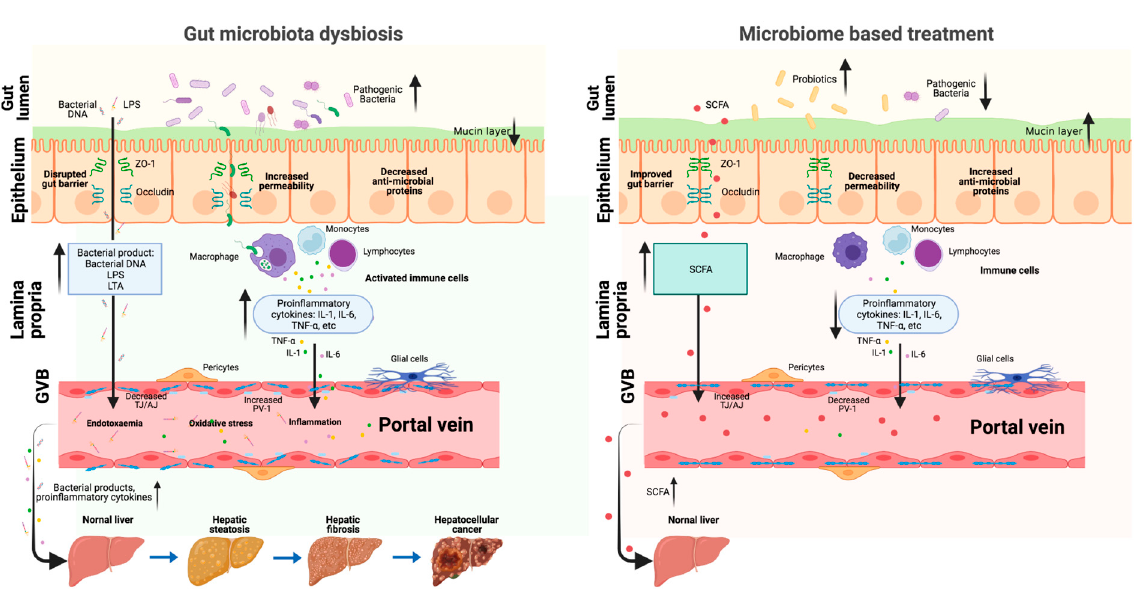
Figure 2. The role of gut–liver axis in the gut microbiota dysbiosis and microbiome-based NAFLD treatment. When the gut microbiota is in homeostasis, it is difficult for the pathogenic bacteria and metabolites to go through the intestinal barrier and reach the liver. When the gut microbiota is dysbiosis, the intestinal barrier is damaged (decreased mucus layer, increased epithelium, and endothelium layer permeability); thus, the pathogenic bacteria and metabolites can easily go through the intestinal barrier, come to the portal system, and finally reach the liver, where they can promote NAFLD progression. Microbiome-based treatment (probiotics and beneficial metabolites) can repair the intestinal barrier and the beneficial metabolites can reach the liver through the portal vein to prevent NAFLD progression (Created with BioRender.com, https://biorender.com/, accessed on 4 February 2022).